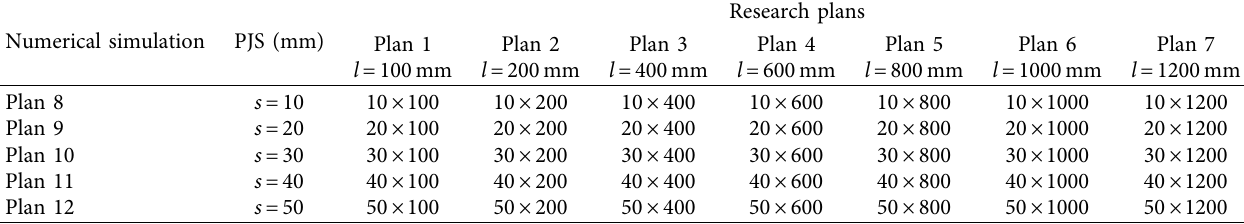
Table 1: Research plans